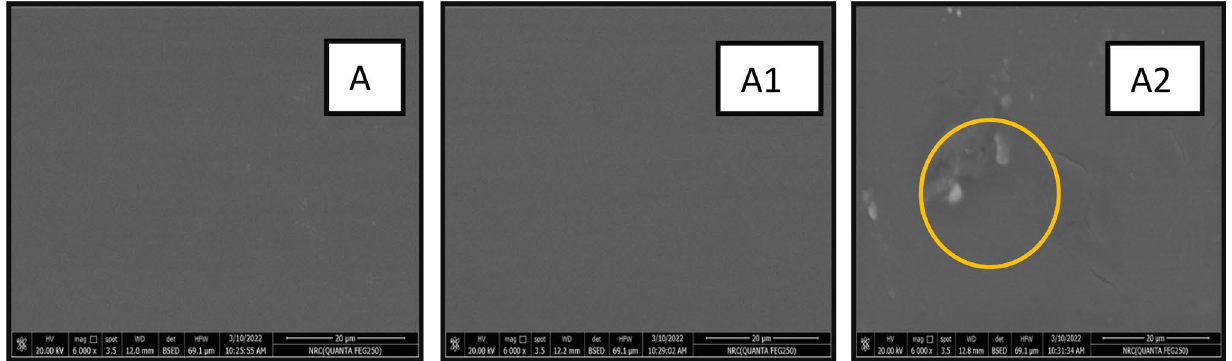
Figure 3. SEM images of samples A, A1, and A2 ( X =